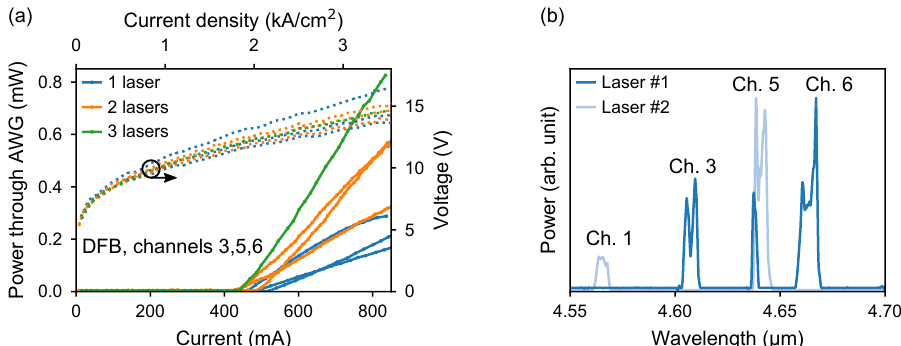
Figure 10. ( a ) LIV plots of a multi-spectral three-channel DFB while driving laser channels 3, 5, and 6. ( b ) Spectra of the three-channel DFB laser (Laser #1) and another two-channel DFB laser (Laser